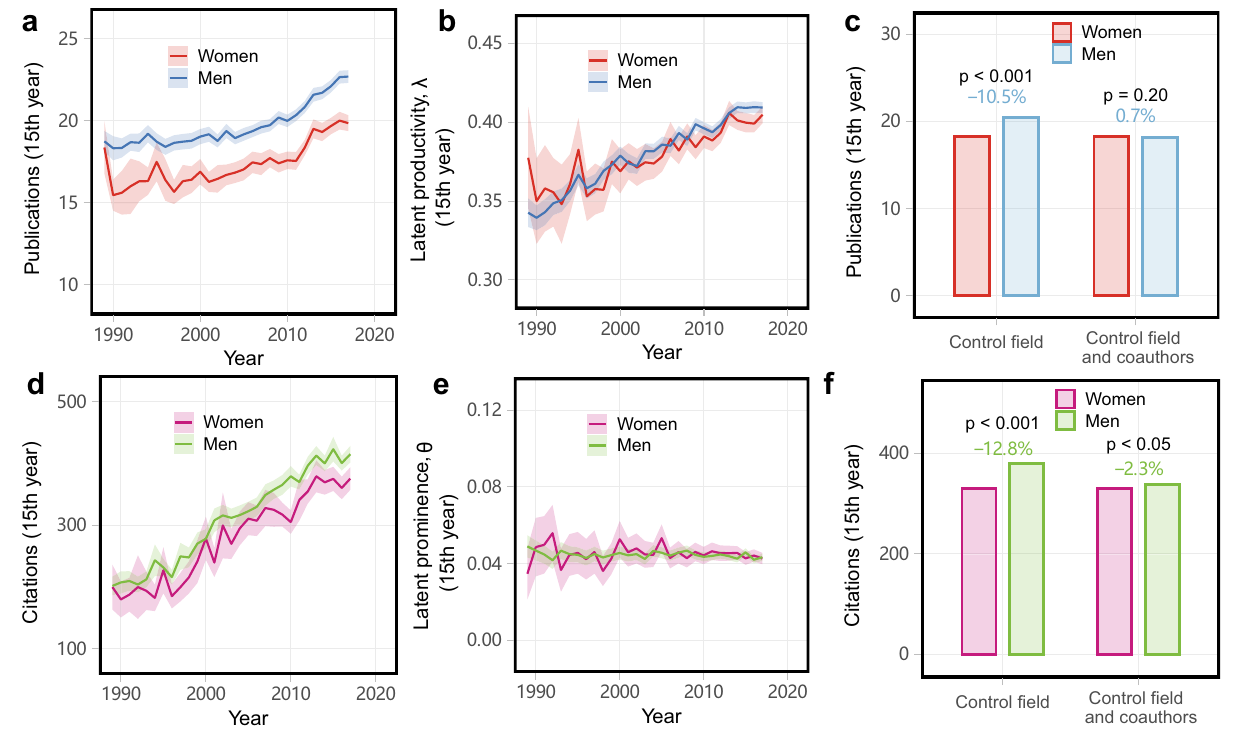
Fig. 2 | Gendered disparities in individual productivity and prominence mea- sures. Across six STEM fi elds, observed average ( a ) productivity and ( d ) promi- nence, showing substantial and stable gaps, among 198,202 mid-career researchers, by gender from 1989 to 2017, along with corresponding estimated individual latent ( b ) productivity λ and ( e ) prominence θ for the same researchers, showing negligible gendered differences. Shaded areas represent 95% con fi dence